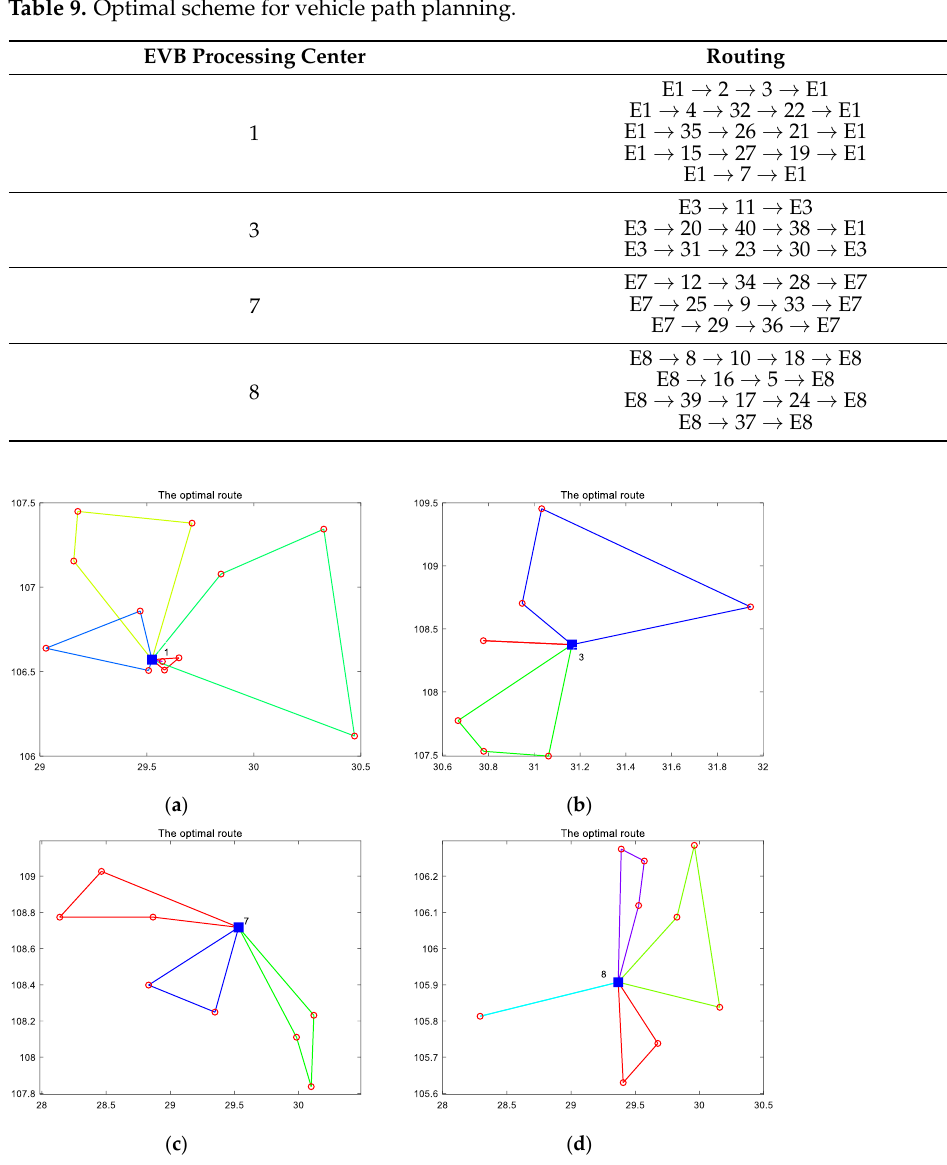
Figure 4. ( a ) Route planning of EVB processing center 1 in scheme 2; ( b ) route planning of EVB processing center 3 in scheme 2; ( c ) route planning of EVB processing center 7 in scheme 2; ( d ) route planning of EVB processing center 8 in scheme 2.